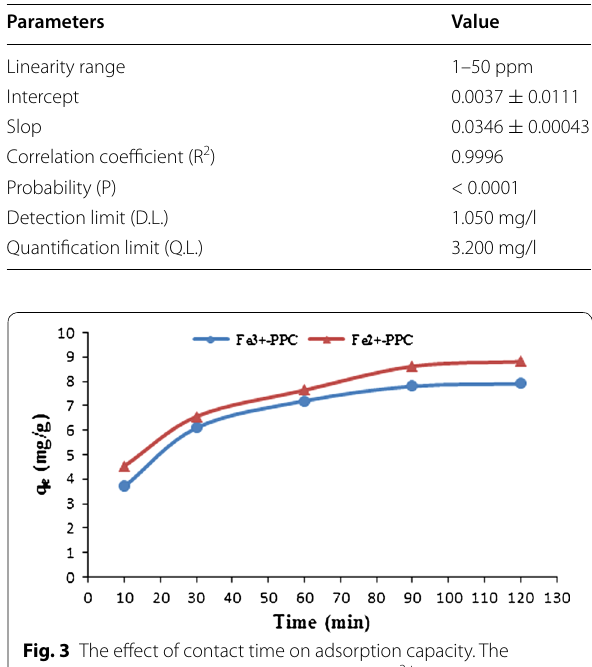
Table 2 Linearity, limit of detection and quantification for the AA